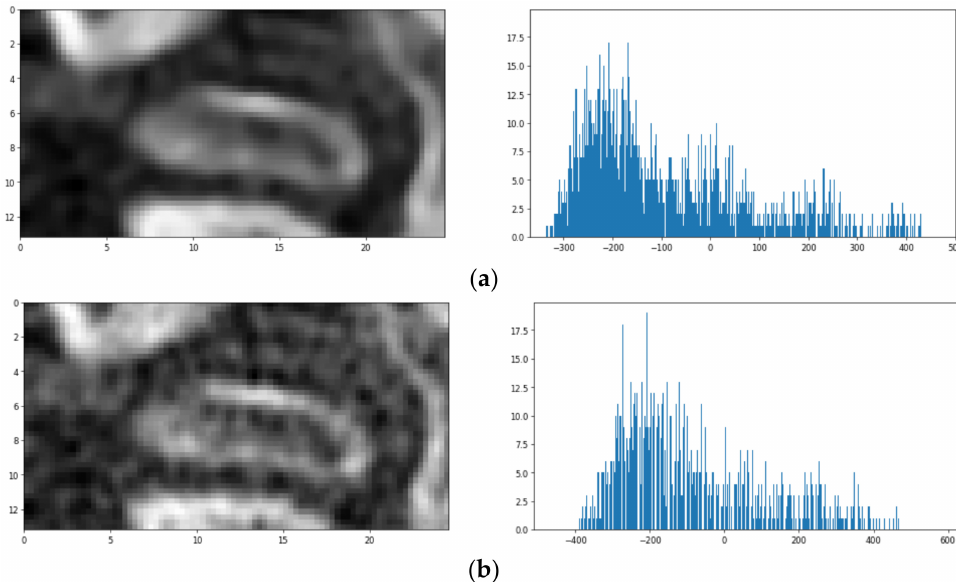
Figure 4. The example of axial slices ( a ) raw and ( b ) denoised and their histograms.